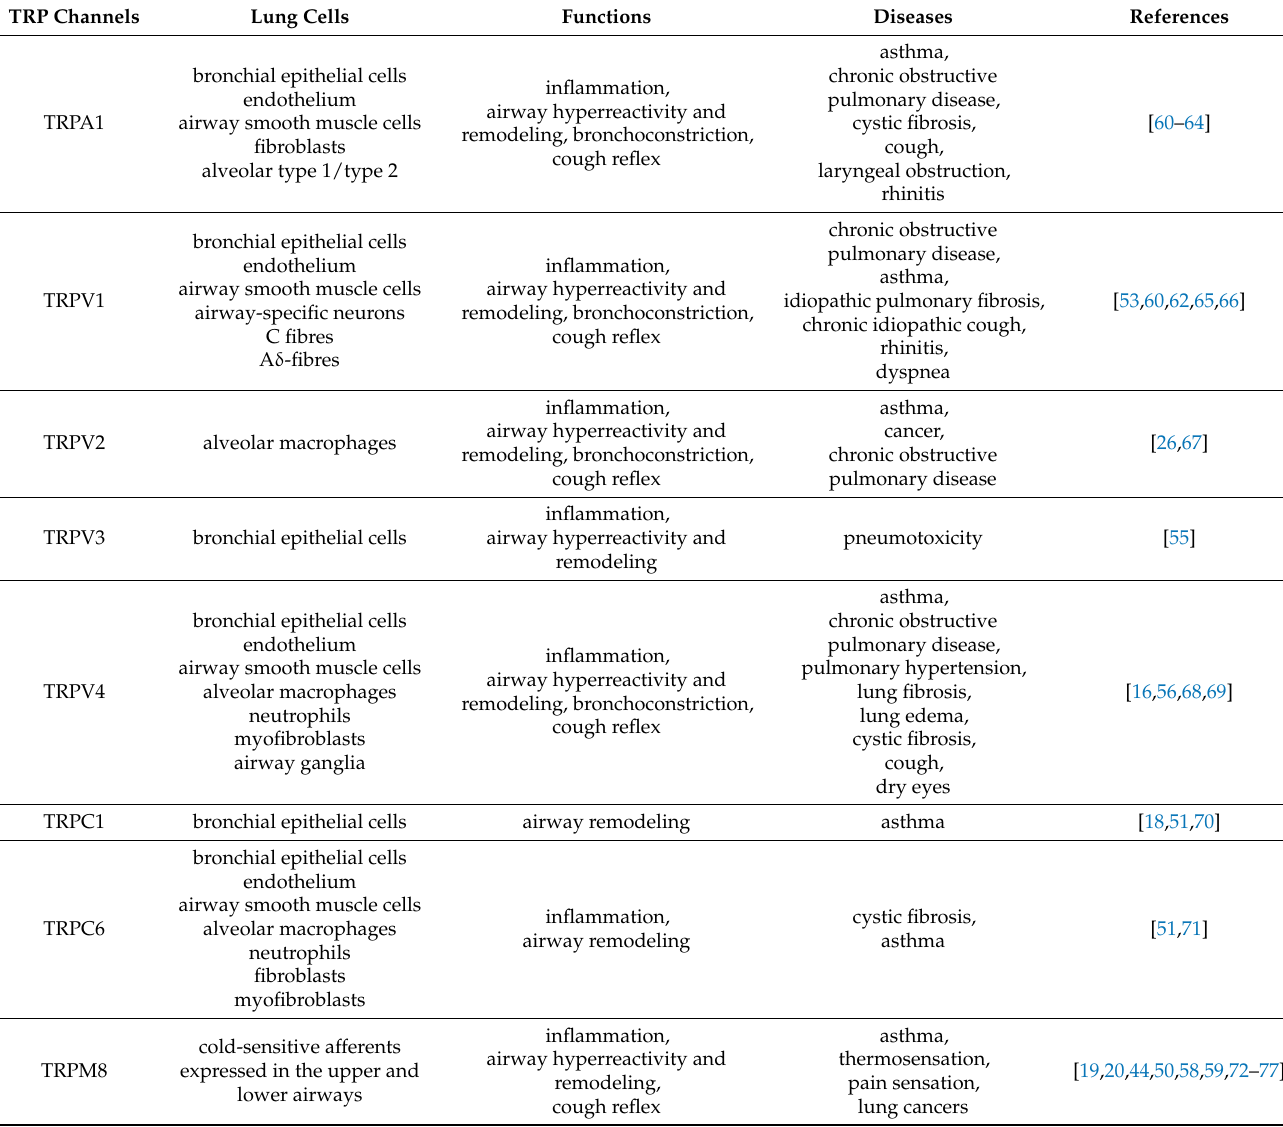
Table 3. Characterization of the superfamily of TRP channels involved in the pathogenesis of bronchopulmonary diseases. TRP